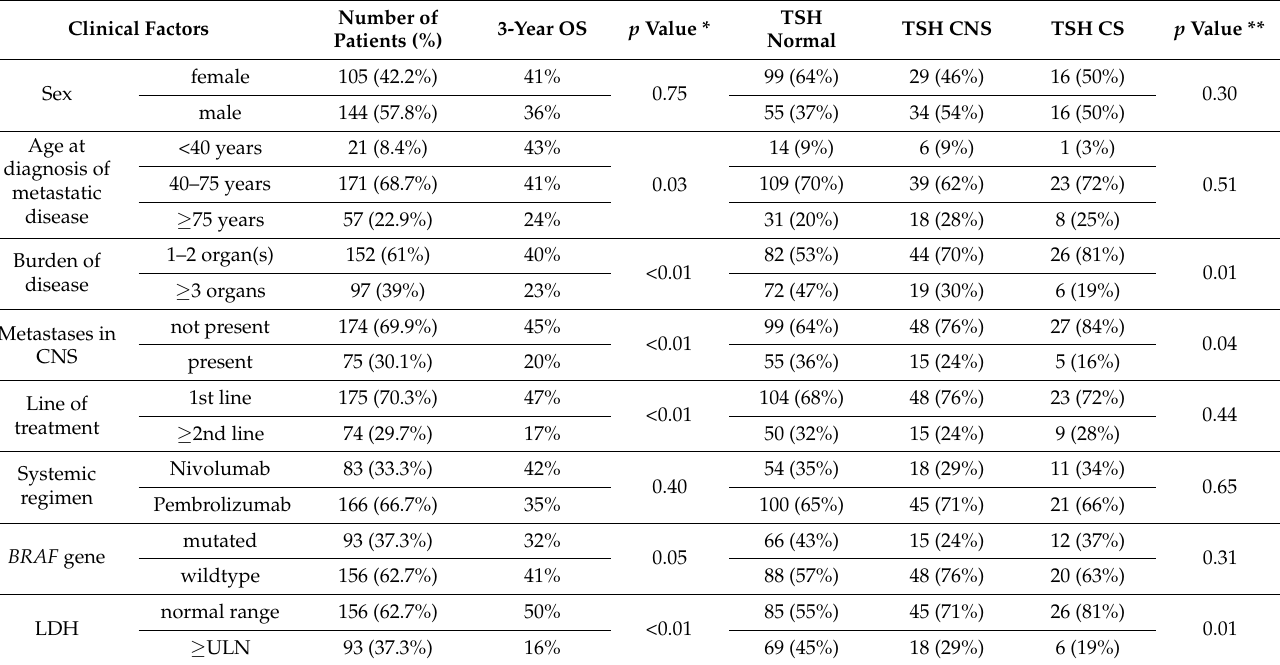
Table 1. Baseline clinical characteristics and 3-year survival of non-operable stage III/IV melanoma patients who underwent PD-1 blockade treatment. (CNS–central nervous system; LDH–lactate dehydrogenase; ULN–the upper limit of